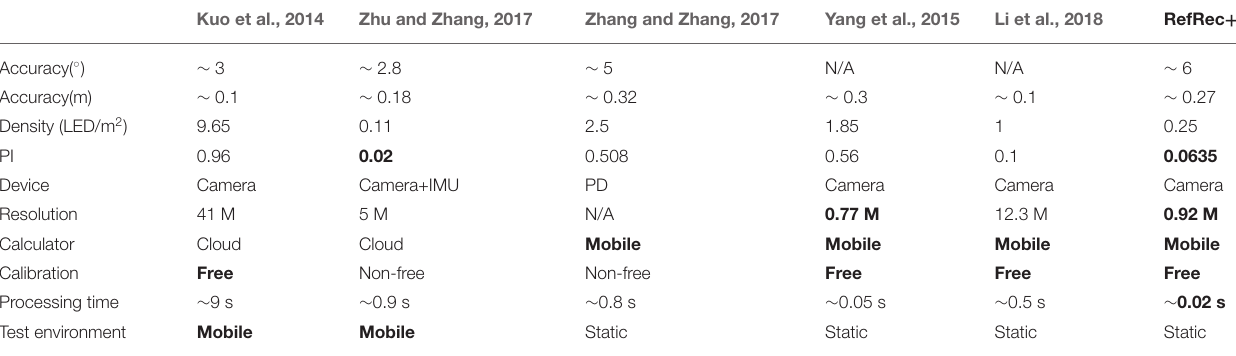
TABLE 1 | Comparison of 6-DOF estimation accuracy with existing VLP methods.